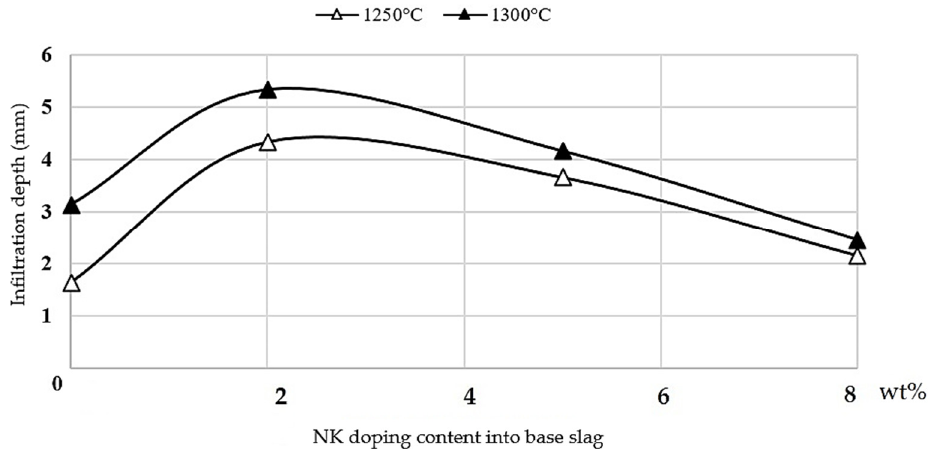
Figure 9. Infiltration depth of NK-doped slag into the refractory material v/s the doping content at 1250 and 1300 °C.